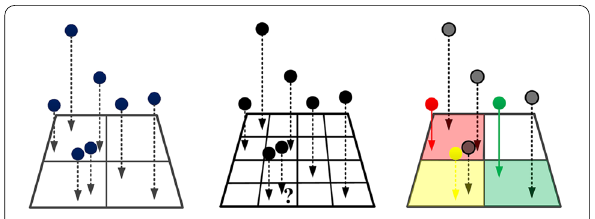
Figure 2 The projection of dense point cloud